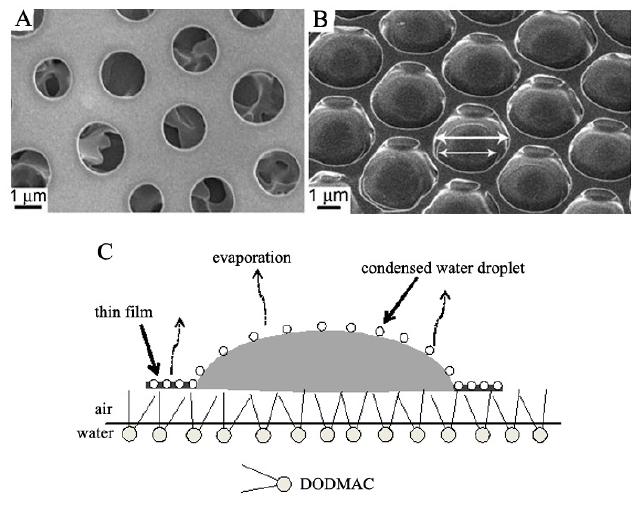
Figure 13. SEM images of the honeycomb structures formed at the gold nanoparticle concentration of 0.8 g/L ( A ) and 0.6 g/L ( B ); ( C ) Schematic diagram of the honeycomb film formation mechanism at air/water interface. The copyright permission was from